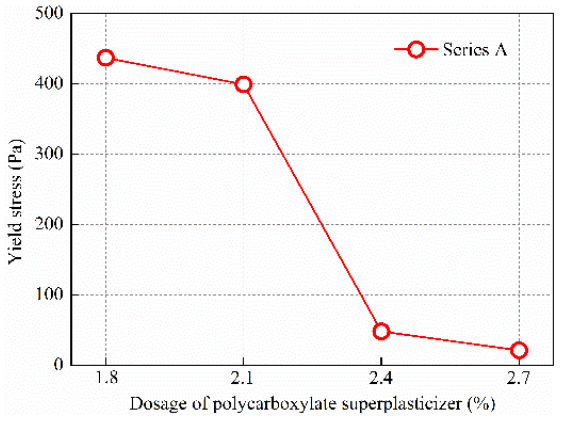
Figure 7. Torque–rotation speed curves of UHPC.